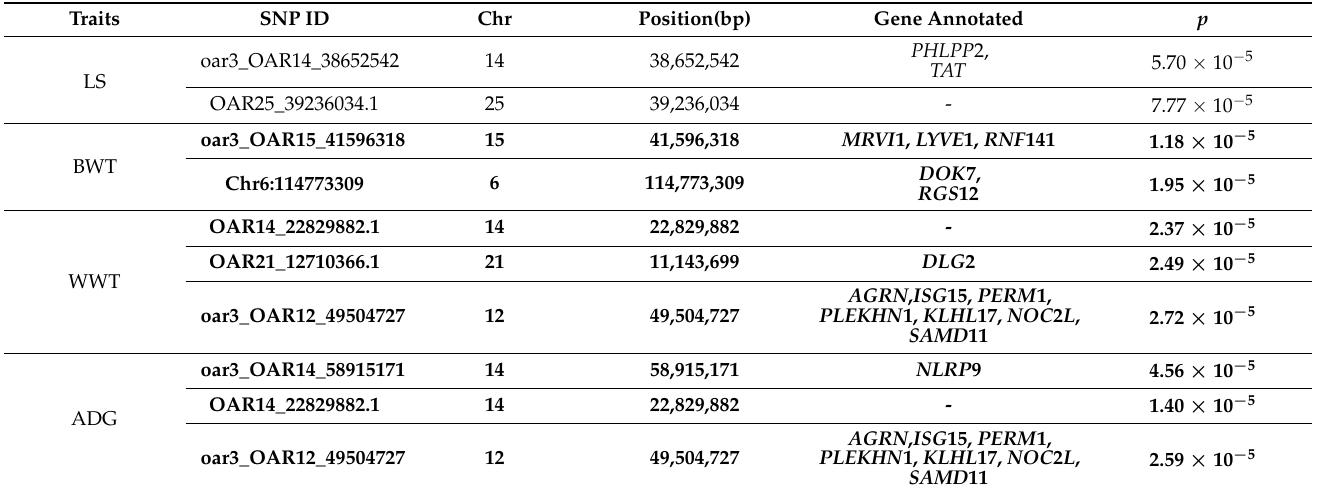
Table 3. Significantly associated SNPs with the re(production) traits in Xinggao sheep.